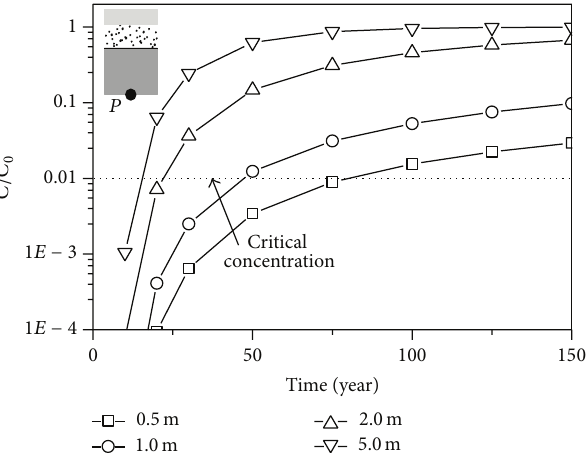
Figure 5: Comparison of numerical results with different water